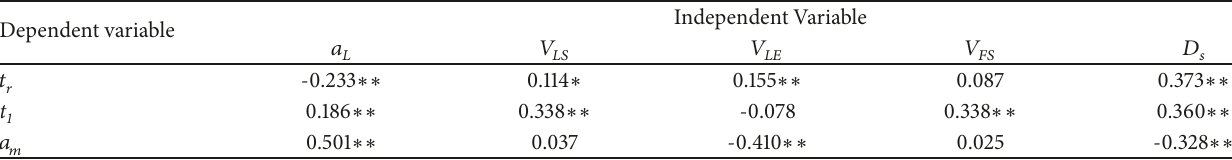
Table 1: Results of correlation